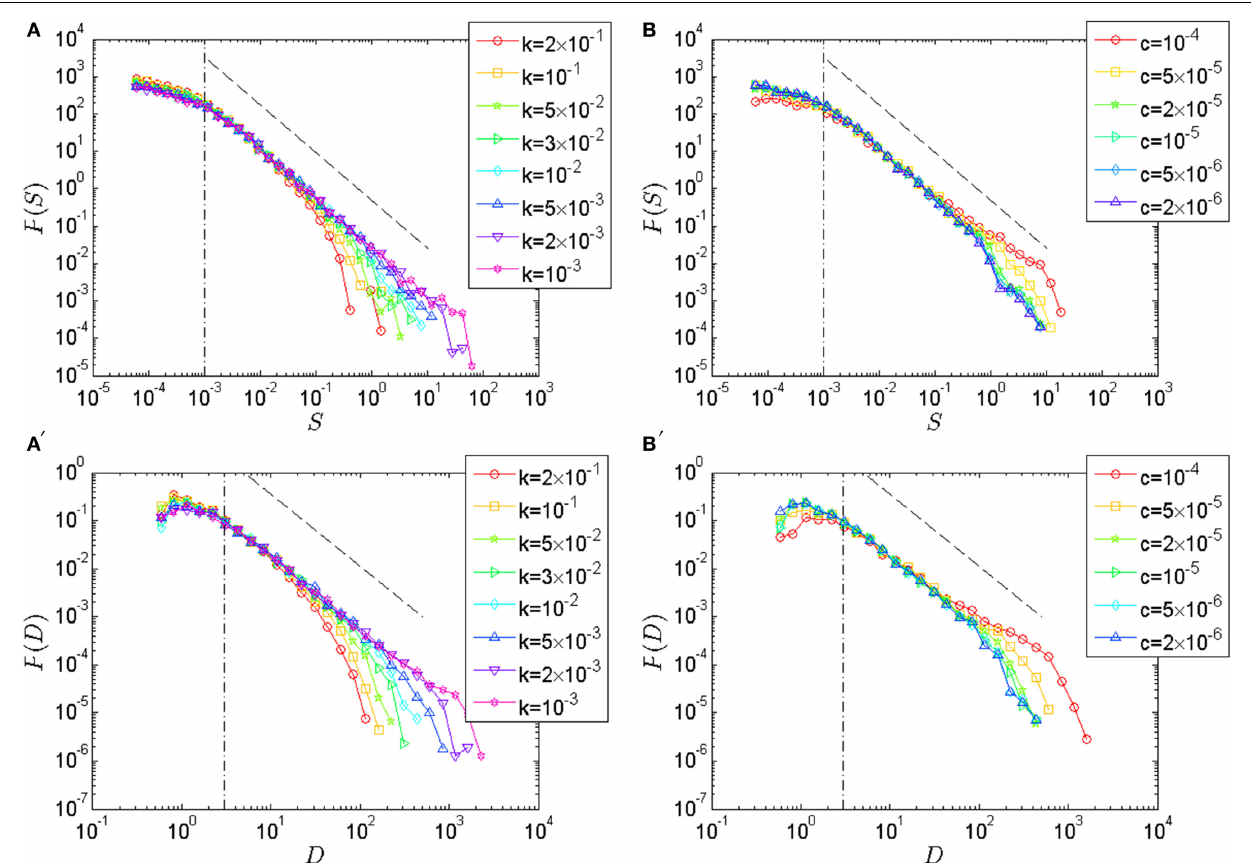
FIGURE 3 | Top: Distribution of the avalanche size measured (A) for various values of k at constant c = 10 − 4 and (B) for various values of c at constant k = 10 − 2 . In both cases, N = 1024 and ˜ η = 1 and the axes are logarithmic. The power-law exponent τ is found to be independent of the parameters and compatible to the universal value τ = 1 . 28 (black dashed line) predicted for c → 0 and k → 0. The lower cutoff is found to be independent of the parameters: S min ≈ 10 − 3 (vertical dash line). The upper-cutoff is found to decrease with k and to increase with c (resp. to be independent of c ) when c is large enough (resp. when c is small enough).